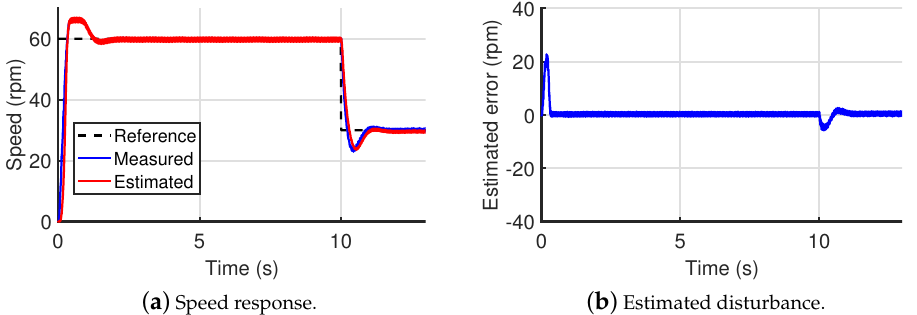
Figure 19. Experimental results of SMO under 60 rpm to 30 rpm.